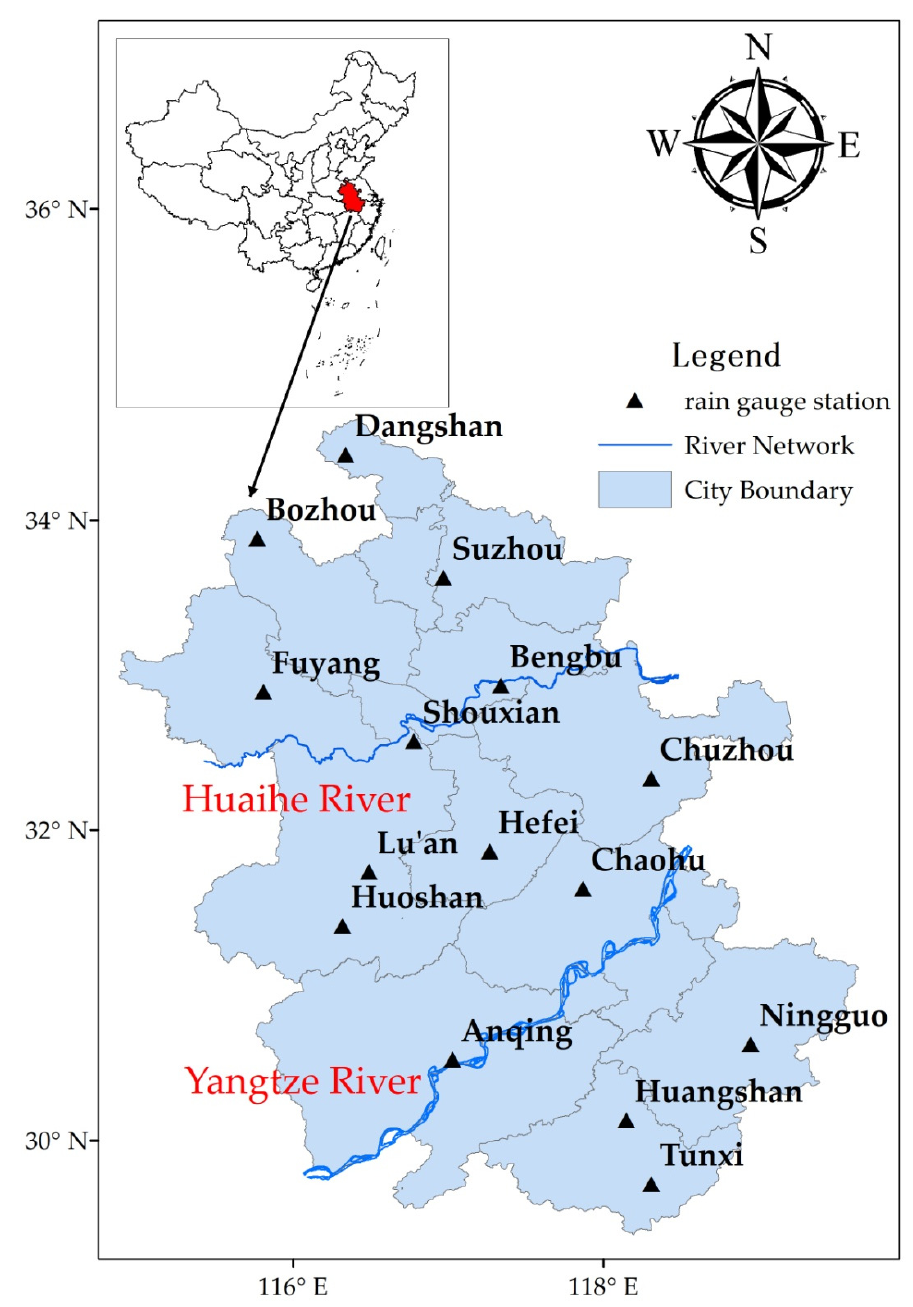
Figure 2. Schematic map of the geographical location and the location of rain gauge stations in the study area.